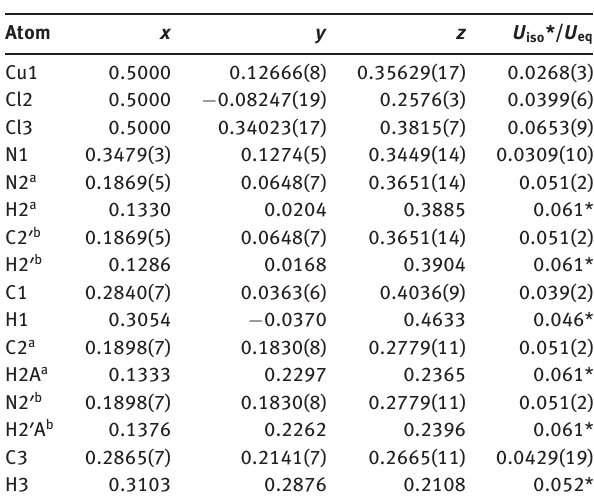
Table 2: Fractional atomic coordinates and isotropic or equivalent isotropic displacement parameters (Å 2